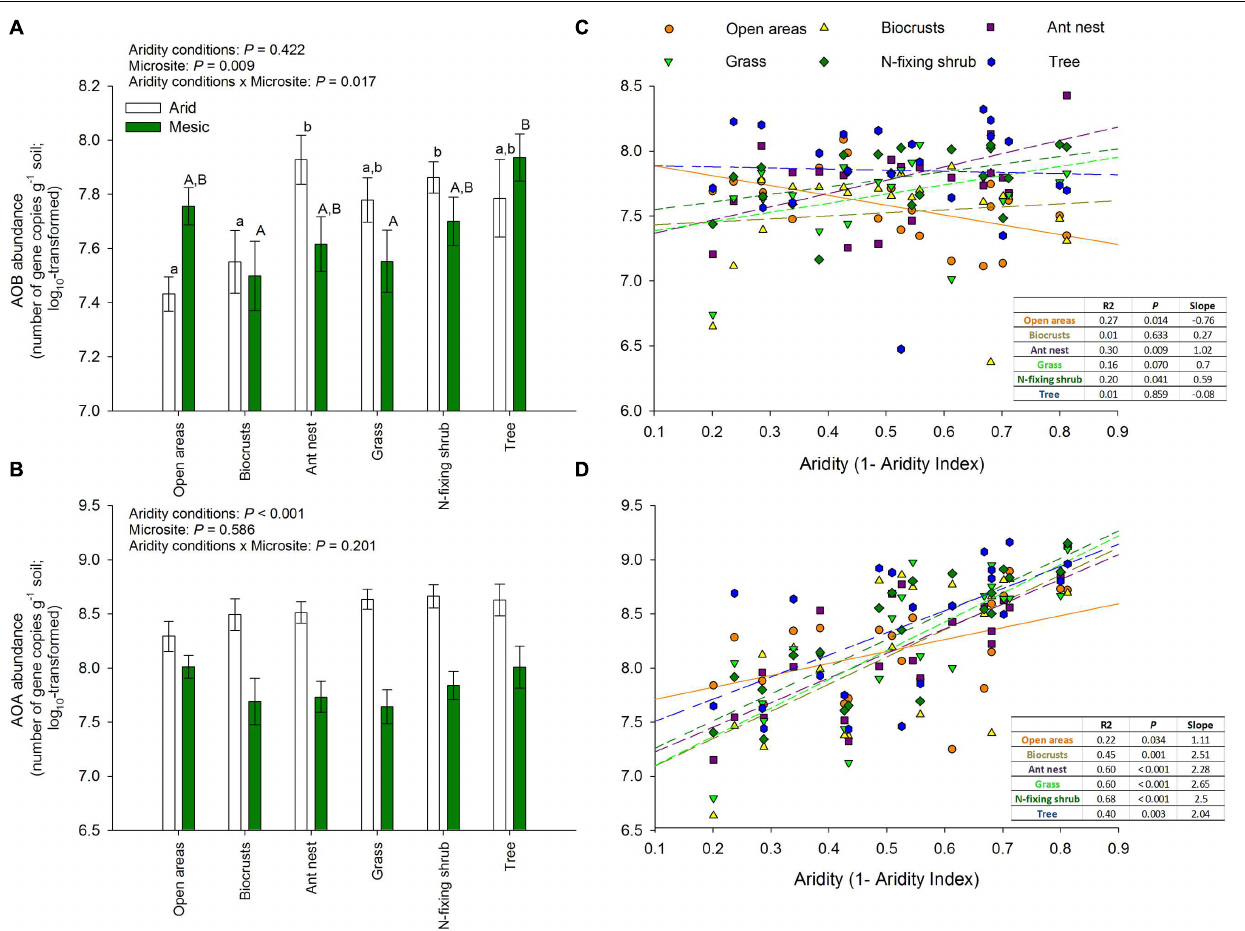
FIGURE 2 | Changes in the abundance of amoA genes from AOB and AOA across different levels of aridity. (A,B) Show mean ± SE, n = 12 and 9 for arid and mesic ecosystems, respectively. Upper case letters indicate differences between microsites (Tukey post hoc test after ANOVA). When interactions between aridity conditions and microsite were found, we conducted post hoc analyses independently for arid and mesic ecosystems. In this case, lower and upper case letters are used to show microsite differences separately for arid and mesic ecosystems. (C,D) Represent linear regressions between aridity and of the abundance of amoA genes from AOB and AOA across different microsites. The solid and dashed lines in (C,D) represent the fitted linear